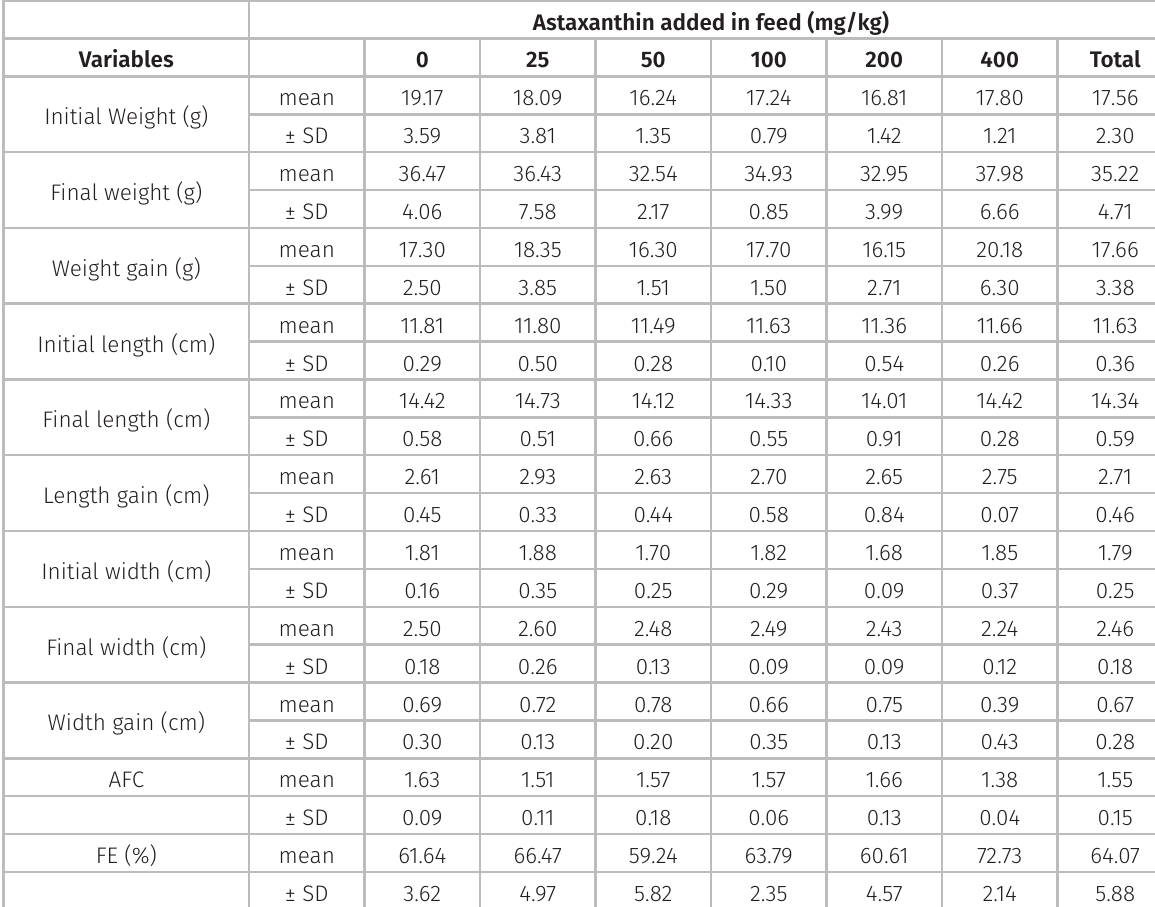
Table I. Zootechnical index in juvenile L. alexandri feed 62 days by diets with different level of synthetic